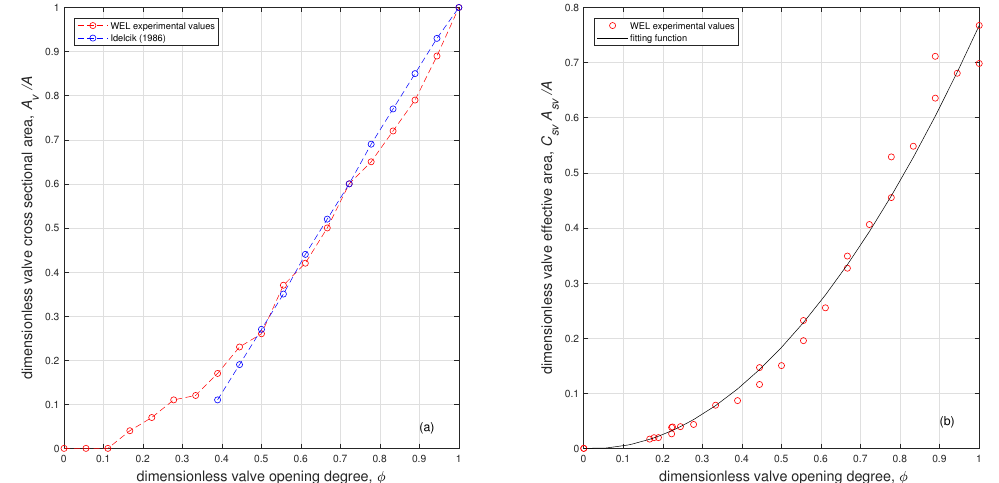
Figure 2. ( a ) Comparison of the geometric characteristics of the ball valve obtained at WEL and by [40]; ( b ) hydraulic characteristics of the end-user.